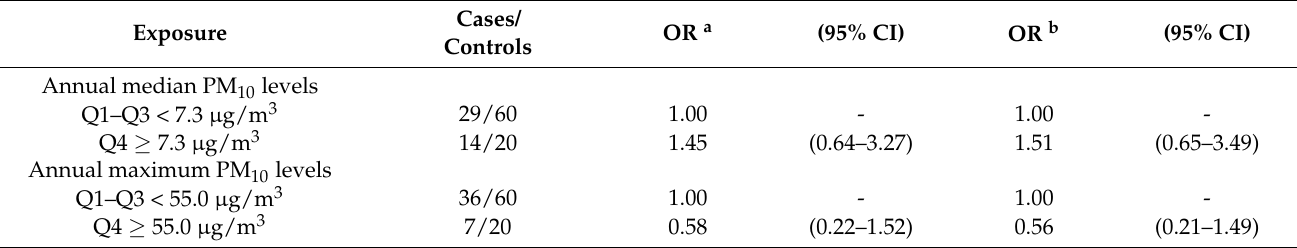
Table 7. Risk of amyotrophic lateral sclerosis according to particulate matter (PM 10 ) exposure in subjects with stable residence within five years of diagnosis comparing the highest and the three lowest quartiles lumped